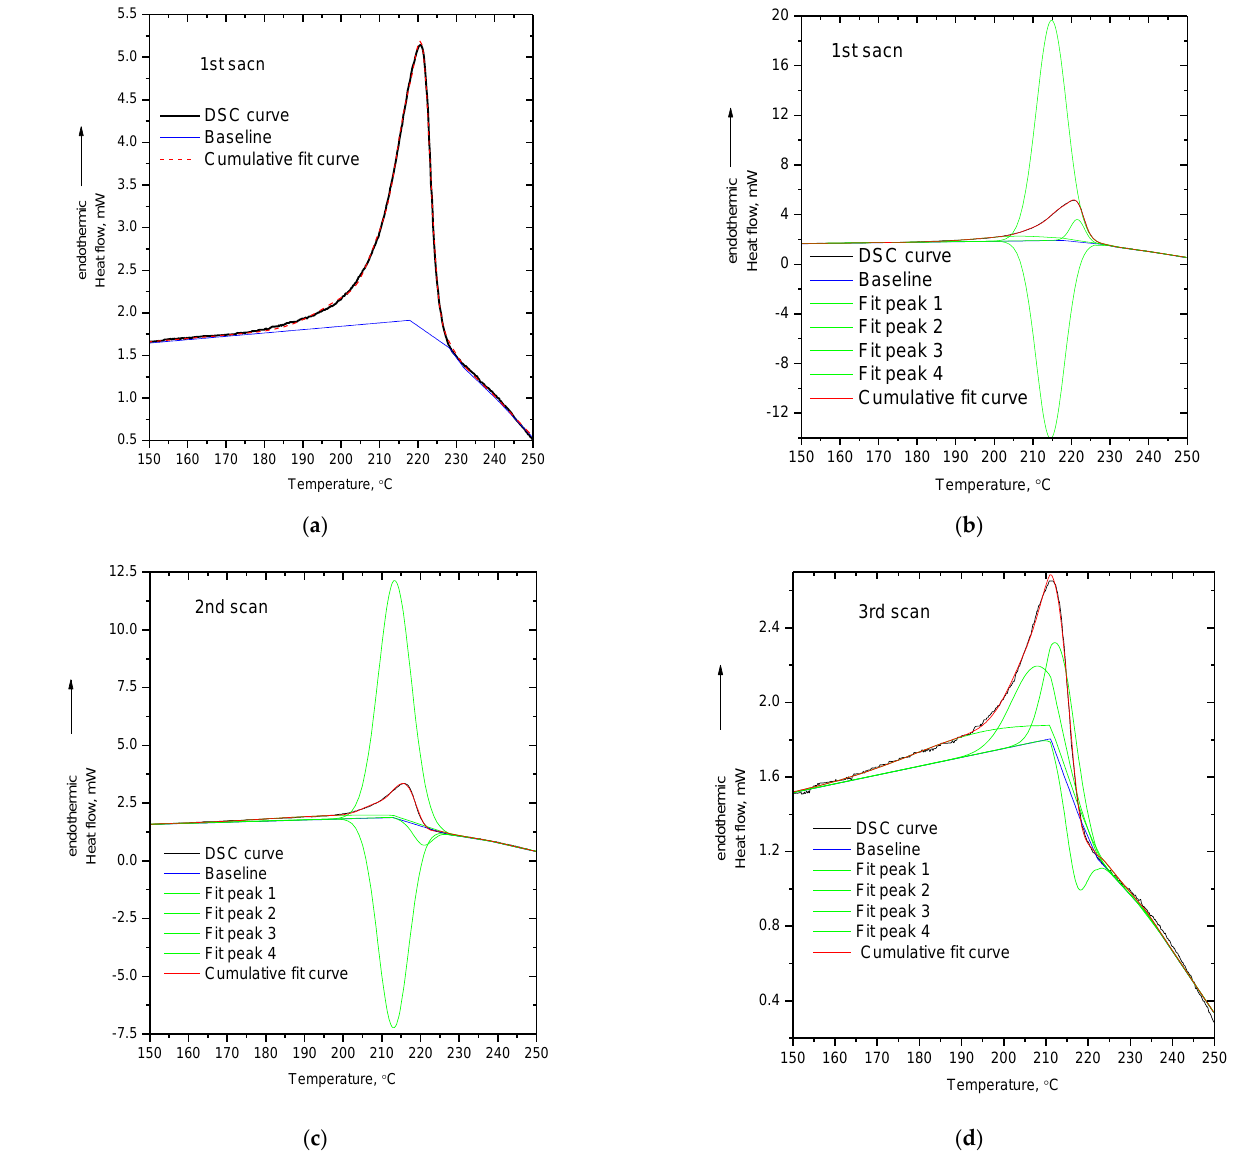
Figure 2. ( a ) DSC curve (first scan) of PVA, cumulative fit peak and baseline used for fitting; ( b ) Fitting of the DSC curve (first scan) of PVA; ( c ) Fitting of the DSC curve (second scan) of PVA; ( d ) Fitting of the DSC curve (third scan) of PVA.